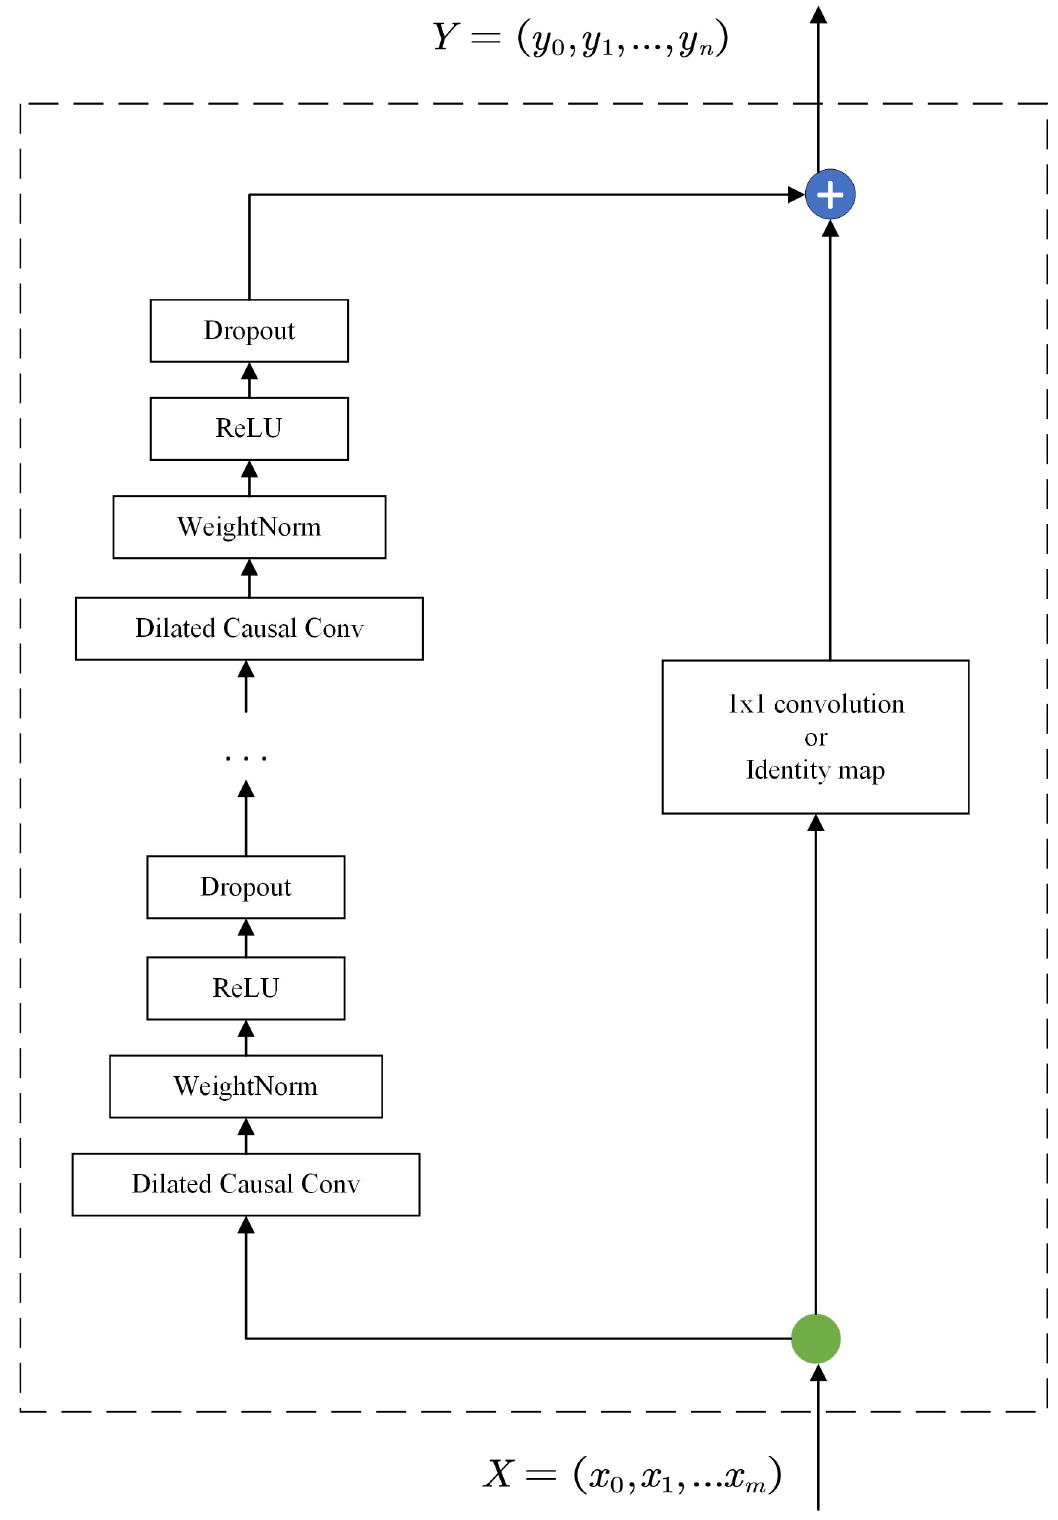
Fig 4. An example of residual connection in a TCN.